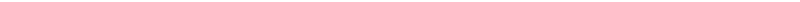
Algorithm 5 Quantity